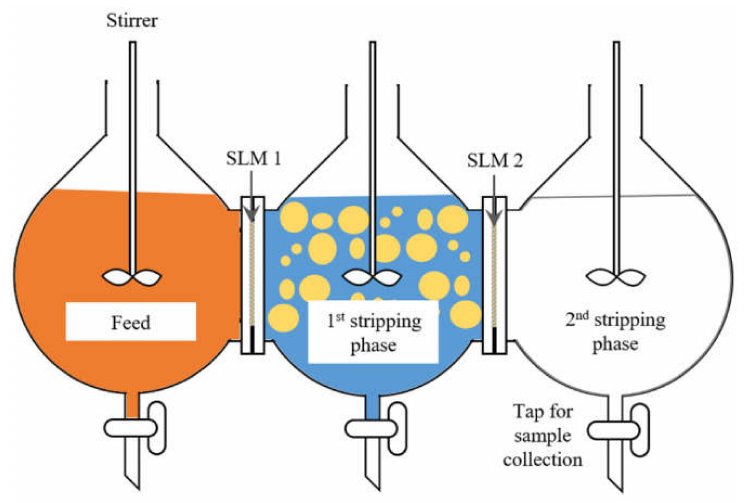
Figure 1. Proposed SLM setup for separation of three types of metal; feed contained 100 ppm chromium (VI), copper and zinc in 0.1 mol/L acetate buffer to maintain suitable pH, two flat